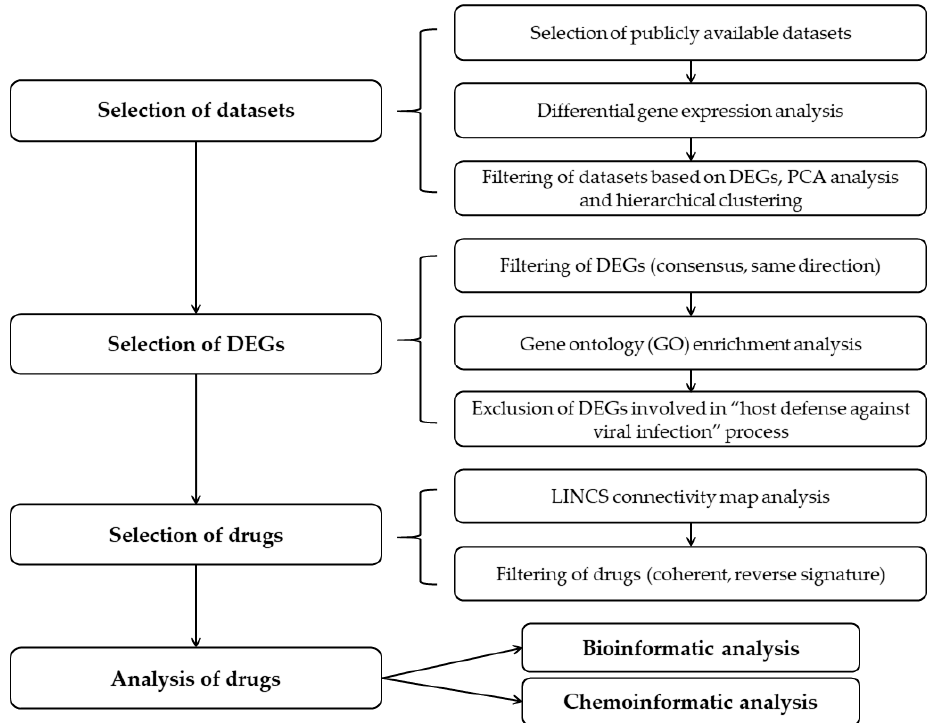
Figure 1. Overall study design for identification of candidate drugs that could reverse transcriptomic signature upon SARS-CoV-2 infection.